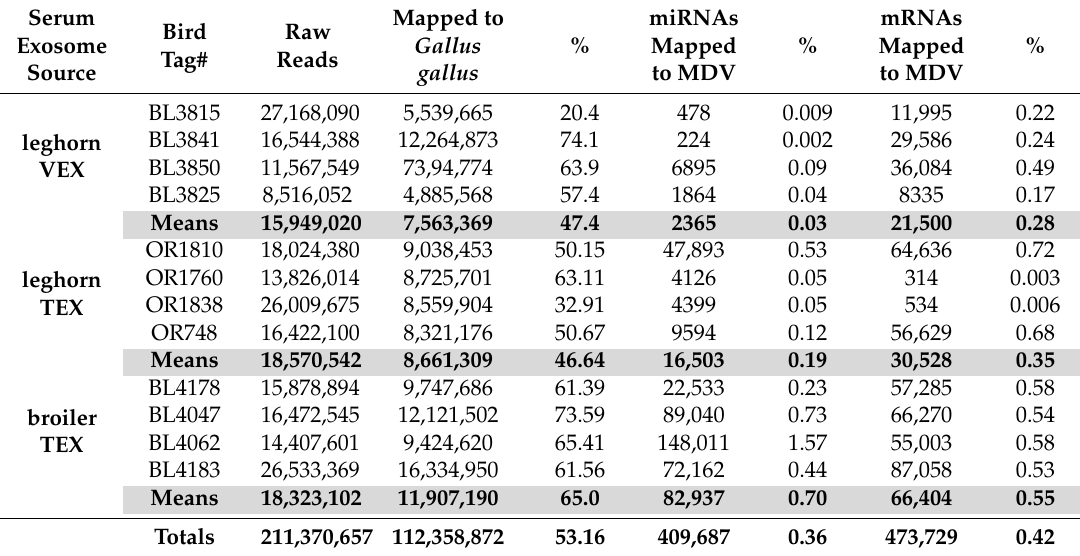
Table 1. Exosome Serum Sources, small RNA, microRNA (miRNA) and mRNA mapping